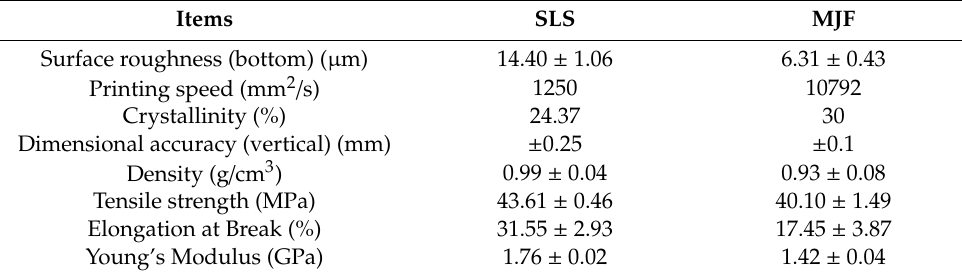
Table 2. Property comparison between SLS and HSS (PA12)